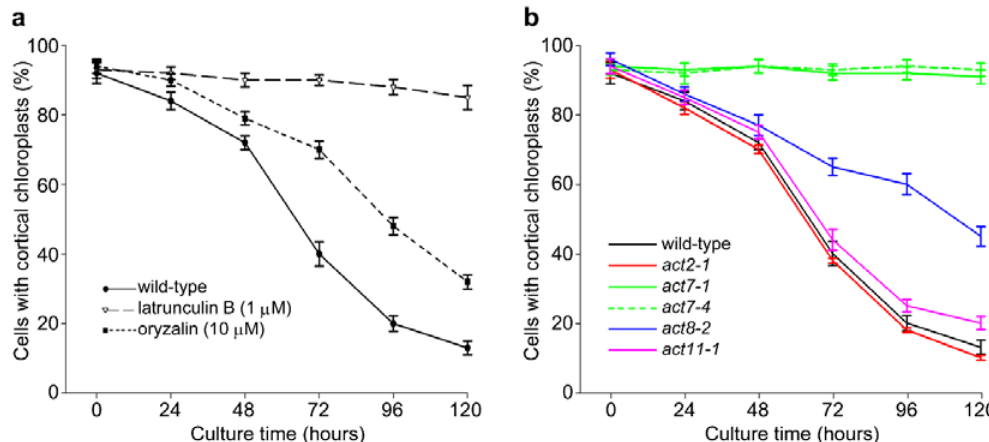
Figure 2. Chloroplast clustering in Arabidopsis protoplasts is actin-dependent and disrupted in act7 mutants. ( a ) Clustering of chloroplasts occurs in Arabidopsis protoplasts. Latrunculin B (1 µ M) inhibited clustering, showing actin-dependence, whereas oryzalin (10 µ M) showed that clustering is independent of microtubules. ( b ) Clustering of chloroplasts around the nucleus is una ff ected in act2-1 or act11-1 protoplasts, is completely inhibited in act7 alleles, act7-1 and act7-4 , and is slowed in act-8-2 protoplasts. Data is mean ± SE, n = 3–5 experiments.